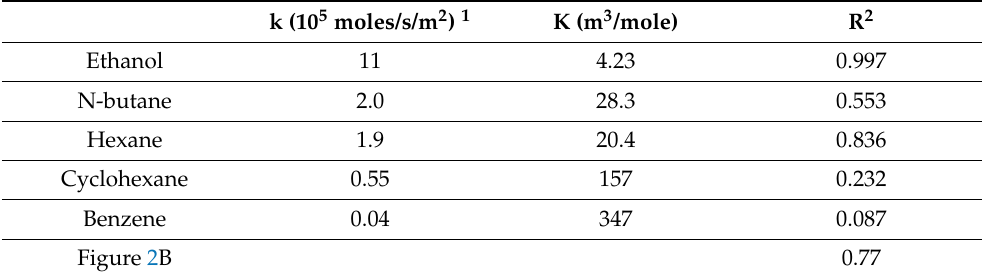
Table 1. Summary of model parameters used to fit the Langmuir-Hinshelwood model to experimental